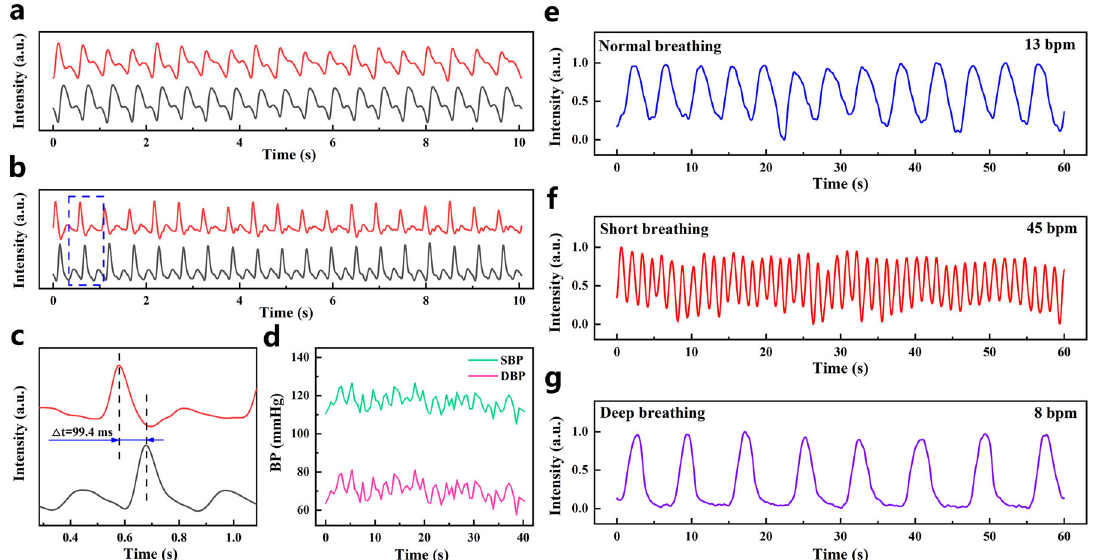
Fig. 3 Flexible sensors for detecting blood pressures and respiratory waves in real time. a Pulse waves from left carotid artery (red) and Index fi ngertip artery (black). b Differential conversion curves of the ones in a . c Enlarged curves for the region marked by a blue virtual box in b showing the pulse transmit time is 99.4 ms. d Systolic blood pressure (SBP) and diastolic blood pressure (DBP) curve obtained in real time by the pulse transmit time. e – g Breathing waves at normal breathing, short breathing, and deep breathing states by a fl exible sensor fi xed on the